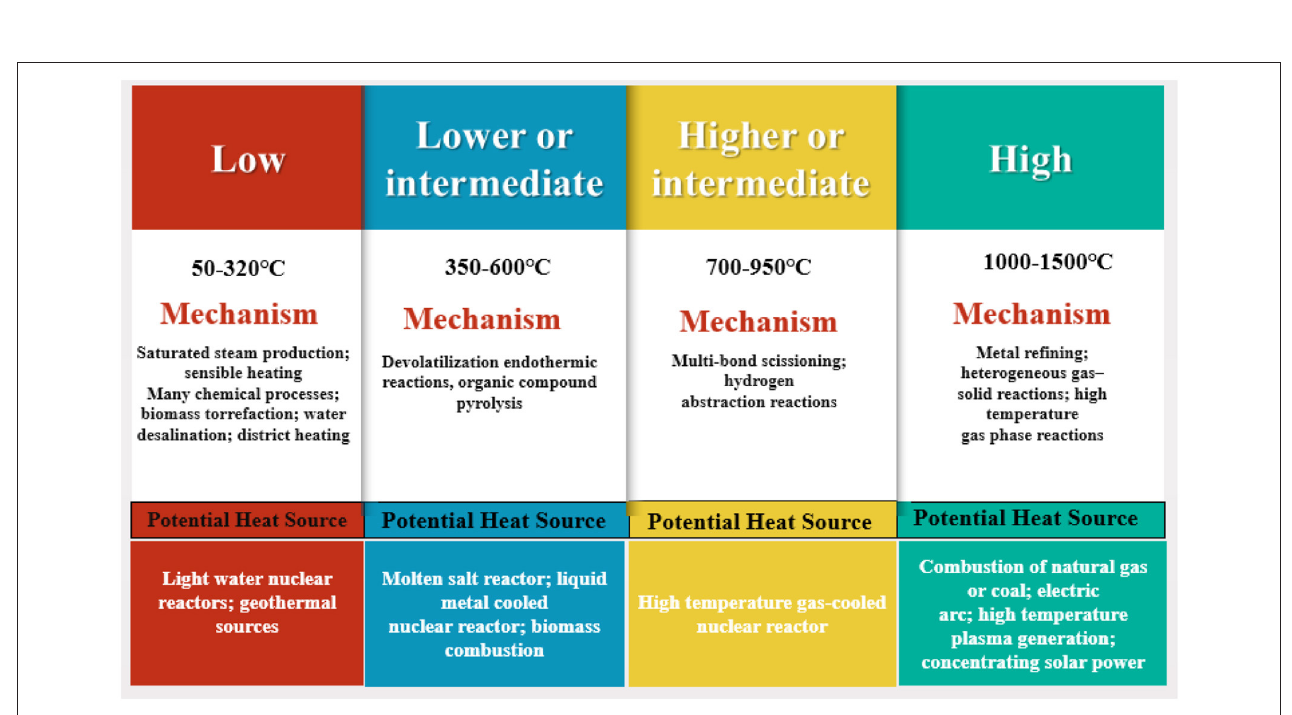
FIGURE 5 | Potential heat sources and mechanisms with temperature ranges (Trippe et al., 2010; Oyeneyin et al., 2012; Ruth et al., 2014).